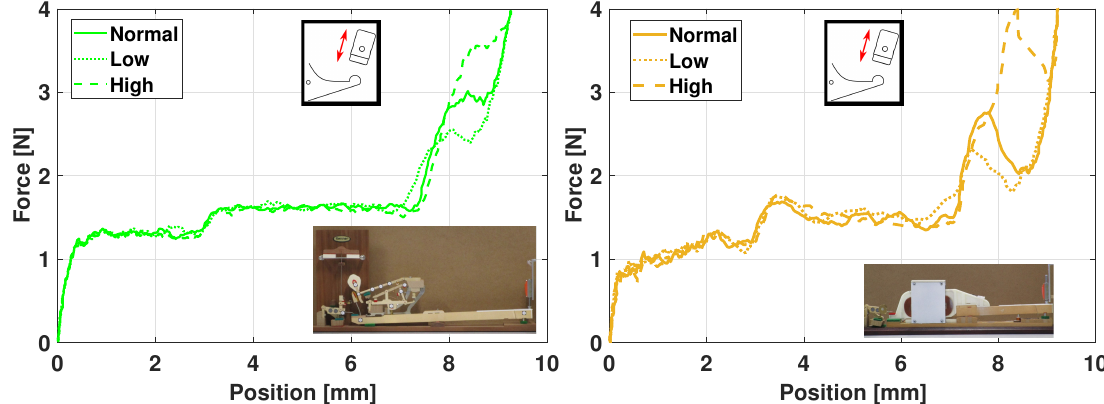
Figure 25. Haptic piano key force validation: variation of the button height, physically on the Renner ® demonstrator ( left ) and virtually on the haptic key prototype ( right